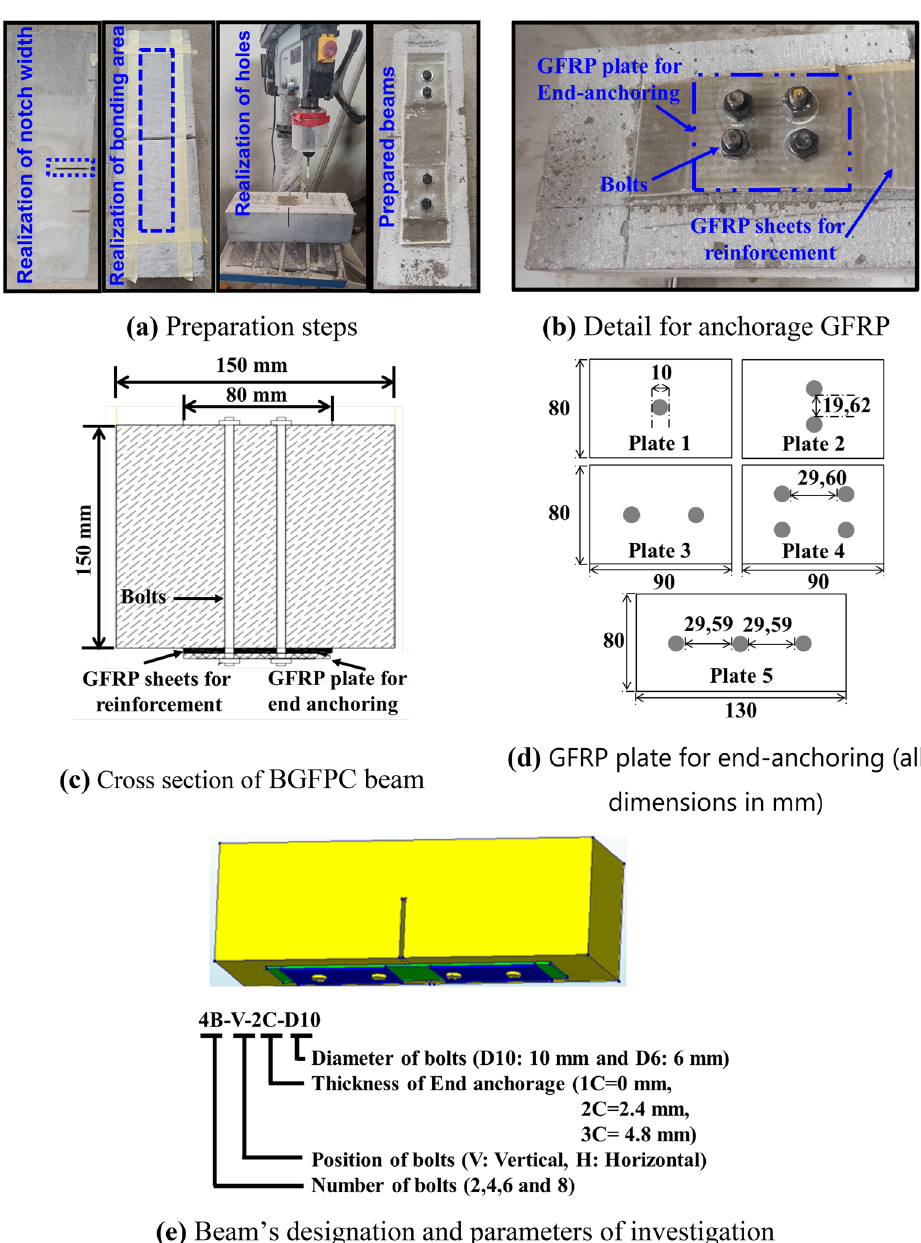
Fig. 2 Preparation of beams strengthened with bolt-glass fiber polymer composites